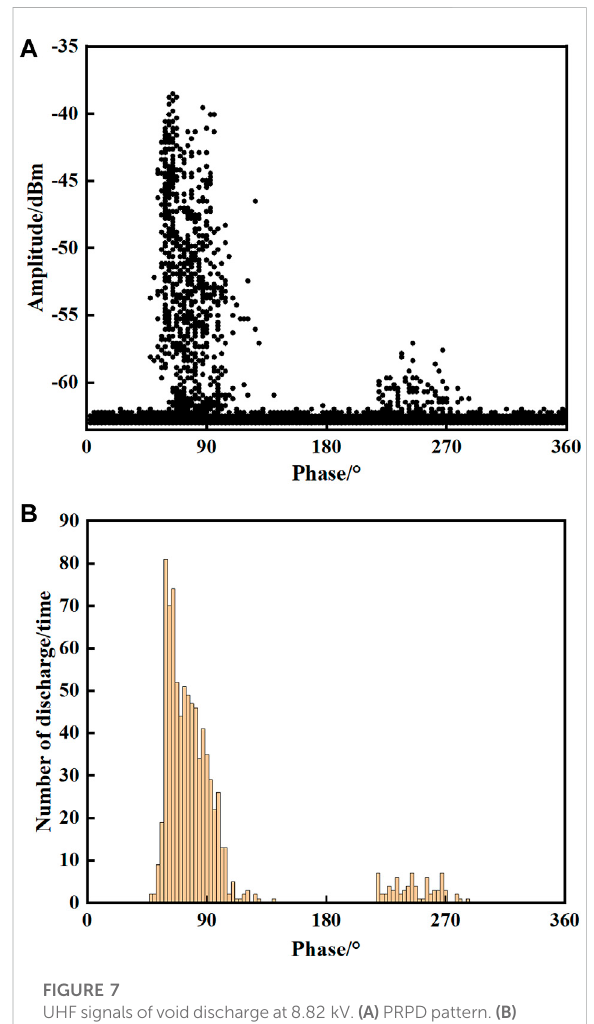
FIGURE 7 UHFsignalsofvoiddischargeat8.82 kV. (A) PRPDpattern. (B) φ − n.